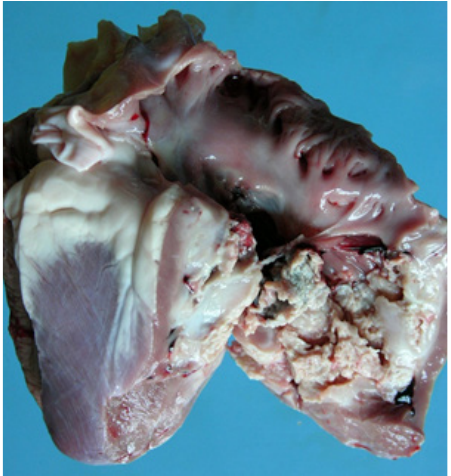
Figura 1. Endocardite mural e valvular por Arcanobacterium pyogenes em caprino. Material amarelado, irregular, vegetante sobre o endocárdio mural do ventrículo direito e na valva átrio ventricular direita.